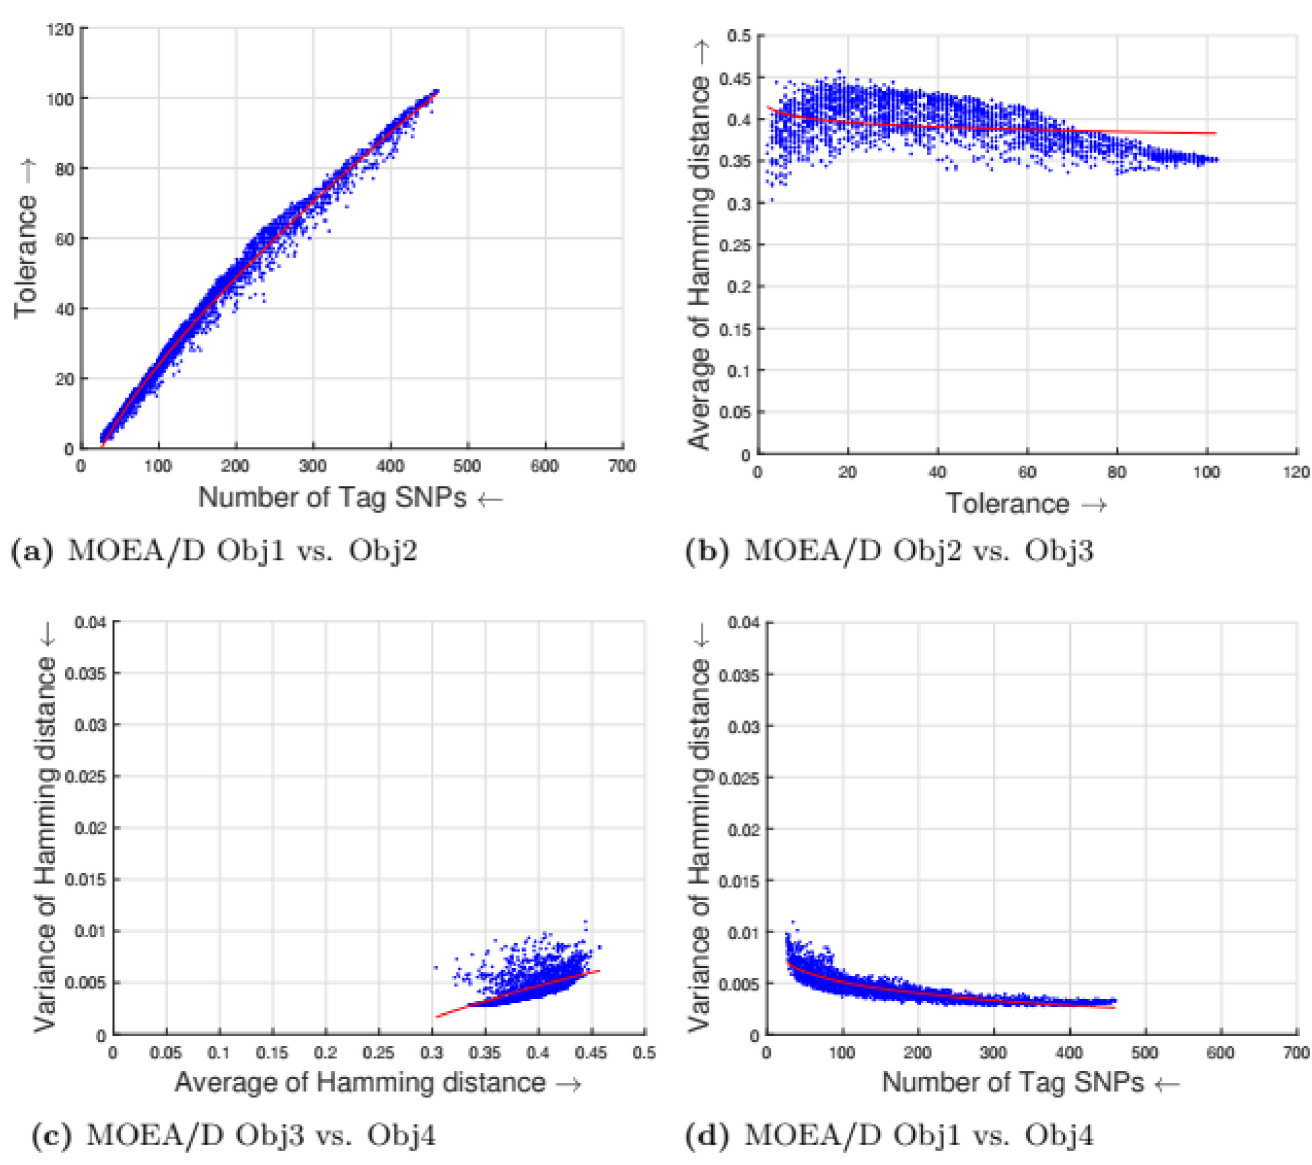
Fig 4. Experimental results of MOEA/D for the tag SNPs selection using random initialization. Obj1 stands for the number of tag SNPs, Obj2 is the tolerance for missing data, Obj3 measures the average Hamming distance between alleles, and Obj4 controls the variance of detection power in each allele. (a) MOEA/D Obj1 vs. Obj2, (b) MOEA/D Obj2 vs. Obj3, (c) MOEA/D Obj3 vs. Obj4, (d) MOEA/D Obj1 vs. Obj4.